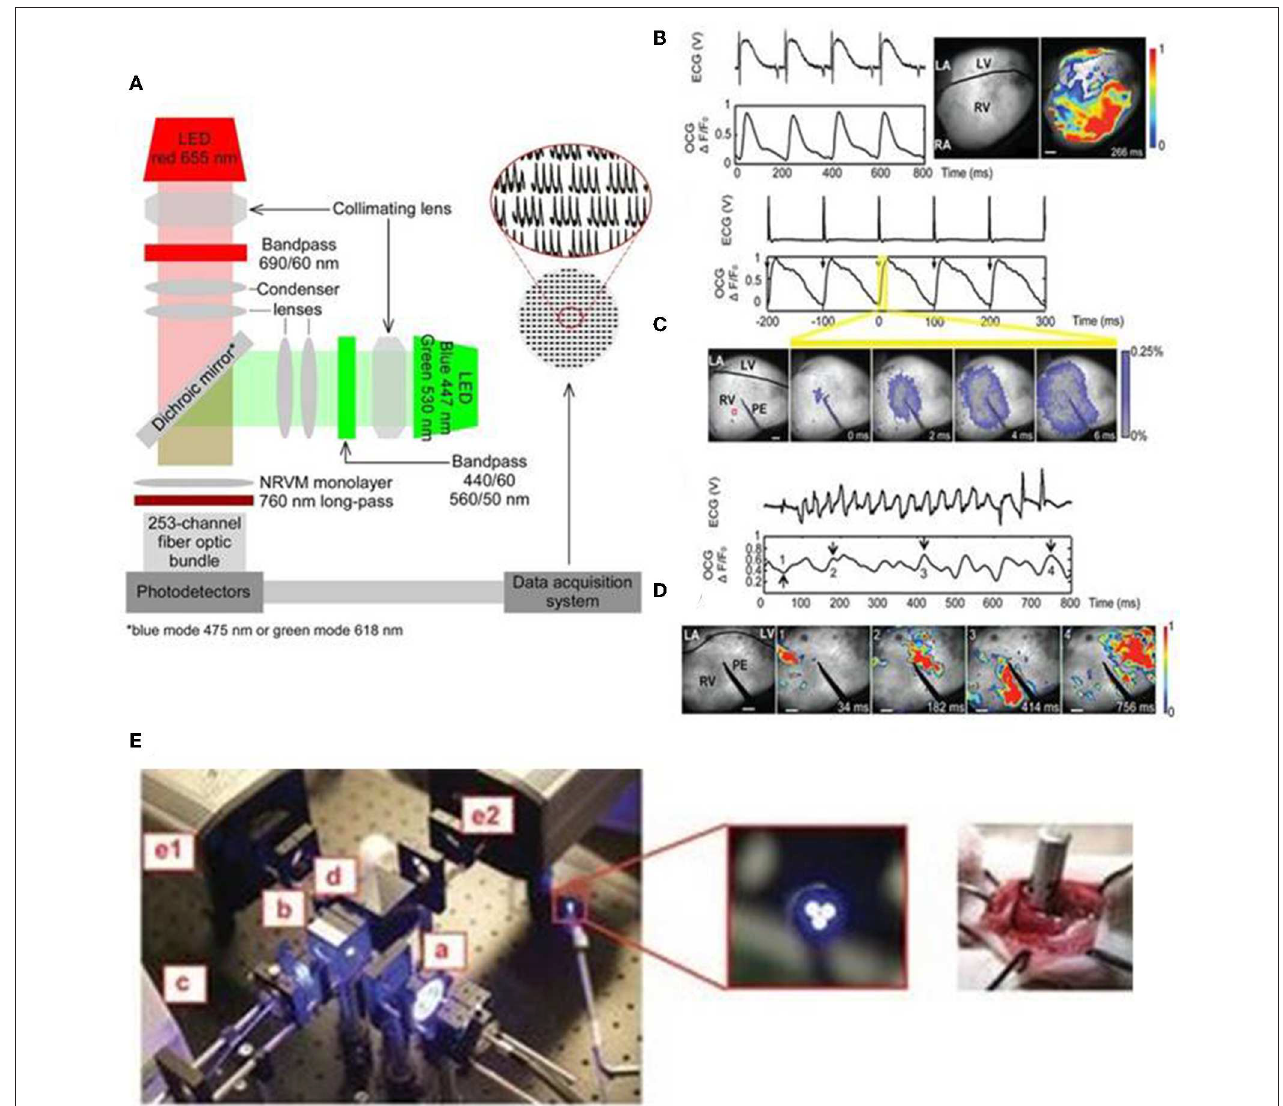
FIGURE 3 | An all optical system by Park et al. includes two LEDs for concurrent stimulation and fluorescence recording from monolayers of ChR2- or eNpHR3.0-expressing neonatal rat ventricular myocyte (NRVM), stained with the voltage-sensitive dye PGH1, appropriate collimating lens, 253-channel fiber optic bundle, photodetectors, and data acquisition system (A) . The generation of optical cardiogram (OCG) waveforms in Langendorff-perfused transgenic mouse hearts expressing the optogenetic voltage sensor VSFP2.3, under the control of the cardiomyocyte-selective MHC promoter, using fast camera system (frame rate 500Hz) (B–D) . OCG recordings were synchronous with the ECG recordings during sinus rhythm (B) . The OCG and ECG recordings showed 1:1 capture during electric pacing at physiological rate (10Hz) using point electrode (PE) (C) . OCG also showed anisotropic spread of signal over time ( C , below), reflecting the physiologic nature of signal propagation. Both ECG and OCG reflected abnormal recordings following induction of ventricular arrhythmia (using 12.5-Hz 200-pulse train) and arrhythmic regions can be located using OCG signal propagation images captured at regular time intervals (D) (Scale bars: 1mm). Fiber optic system ( E , left) also tested to record OCG signals from the intact hearts of transgenic mice, expressing VSFP2.3, in a minimally invasive manner. The fiber optic system consists of light source (a), excitation filter (b), optical fiber bundle (c), emission filter (d), cameras for capturing CFP, and YFP fluorescence signals (e1 and e2) ( E , middle: magnified image showing tip of fiber bundle; right: image showing direct placement of fiber bundle against the functioning heart in situ ). Reproduced with permission from Park et al. (2014) and Chang Liao et al.